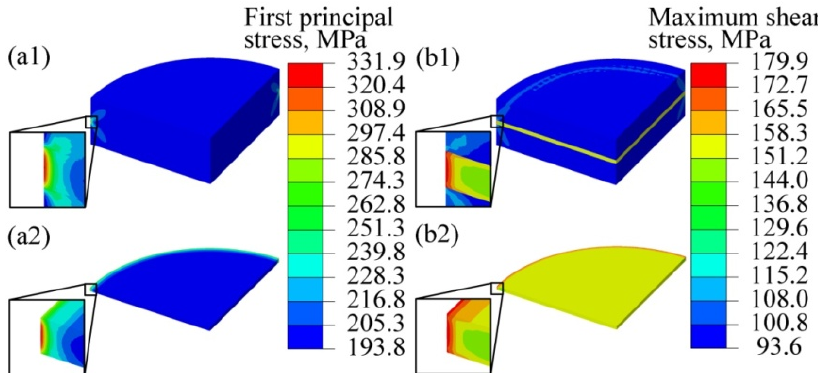
Figure 3. Simulation results of first principal stresses and shear stress: first principal stress in ( a1 ) the TLP bonded joint and ( a2 ) the intermediate layer; and shear stress in ( b1 ) the TLP bonded joint and ( b2 ) the intermediate layer.